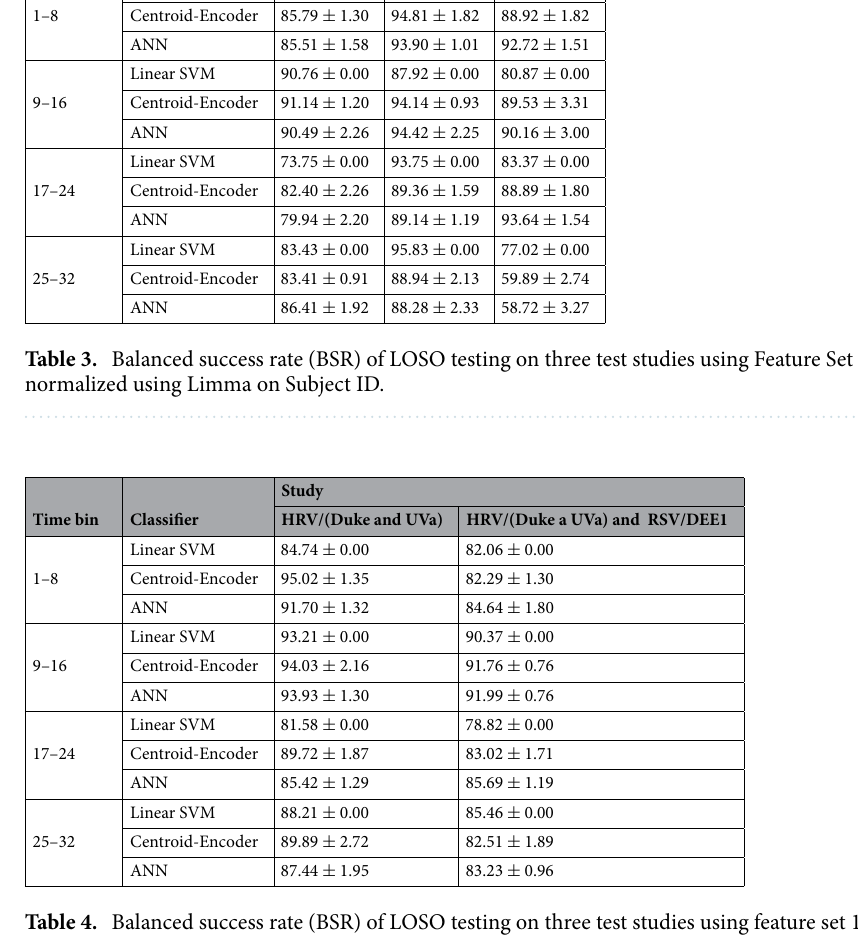
Table 4. Balanced success rate (BSR) of LOSO testing on three test studies using feature set 1. Limma is applied using subject ID to normalize the